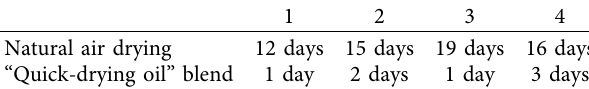
Table 3: Oil painting drying time.